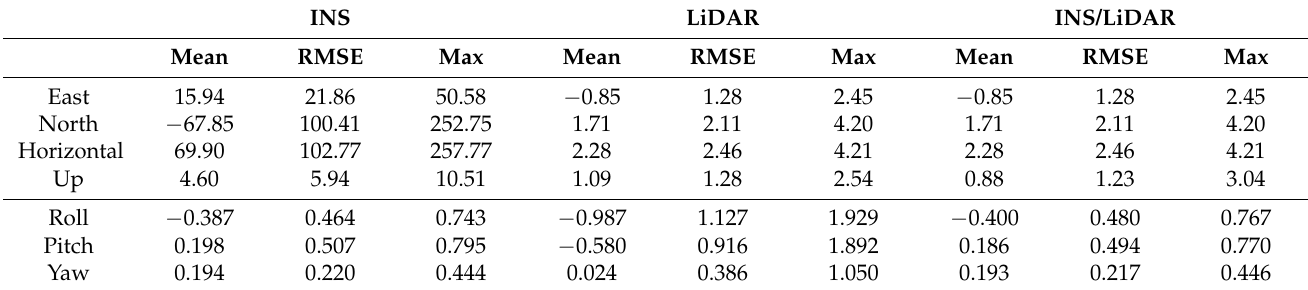
Table A10. D-36—position (m) and attitude (deg) error statistics.